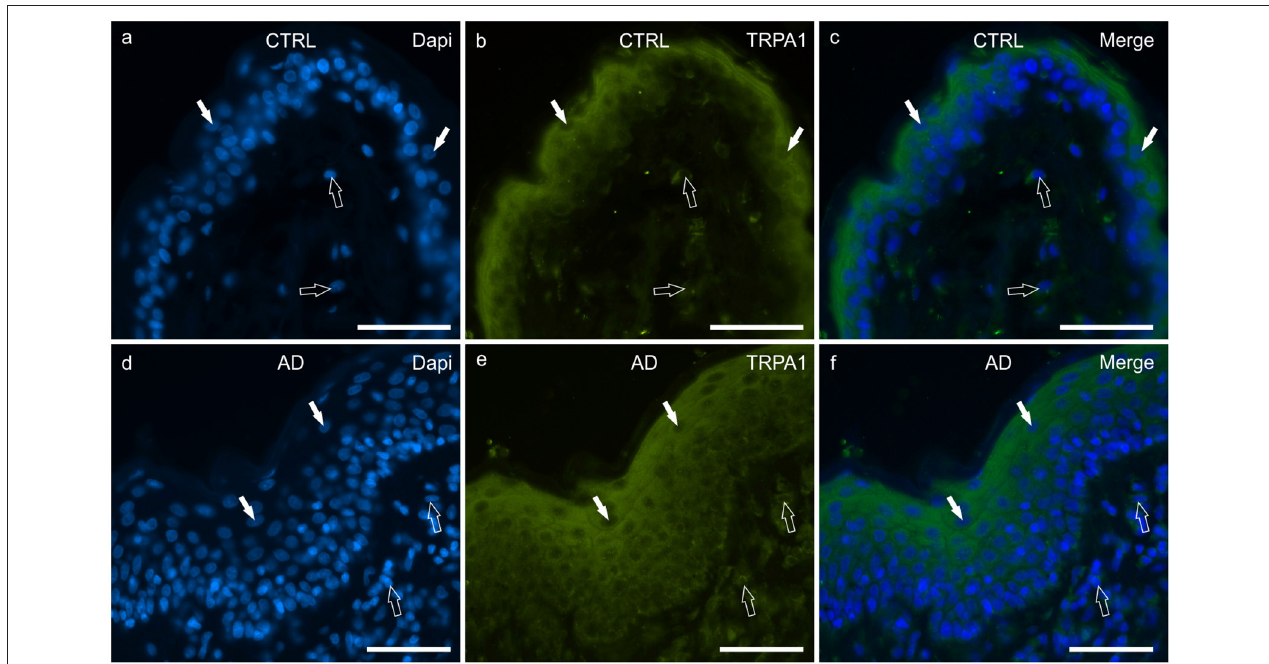
FIGURE 6 | Photomicrographs of cryosections of canine skin showing transient receptor potential ankyrin 1 (TRPA1) immunoreactivity (IR) in the tissues of the healthy dogs (CTRL) (a–c) and in the dogs with atopic dermatitis (AD) (d–f) . (a–c) The white arrows indicate some DAPI-labeled nuclei of the keratinocytes of the CTRL dogs showing moderate cytoplasmic TRPV1-IR. The TRPA1 immunolabelling was brighter in the more superficial cells. The open arrows indicate some DAPI-labeled nuclei of the dermal cells showing moderate TRPV1-IR. (d–f) The white arrows indicate some DAPI-labeled nuclei of the keratinocytes of the AD dogs showing bright cytoplasmic TRPV1-IR. Not all the cells of the suprabasal layer showed the same degree of TRPA1-IR which was brighter in the cytoplasm of the more superficial cells. The open arrows indicate some DAPI-labeled nuclei of the dermal cells showing bright TRPA1-IR. Bar, 50 µ